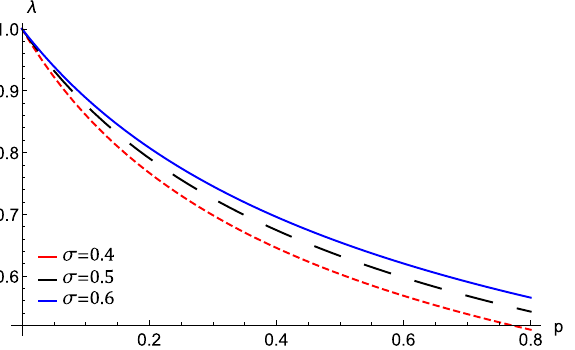
Figure 1. The phase velocity (cid:31) , variation against p at different values of σ